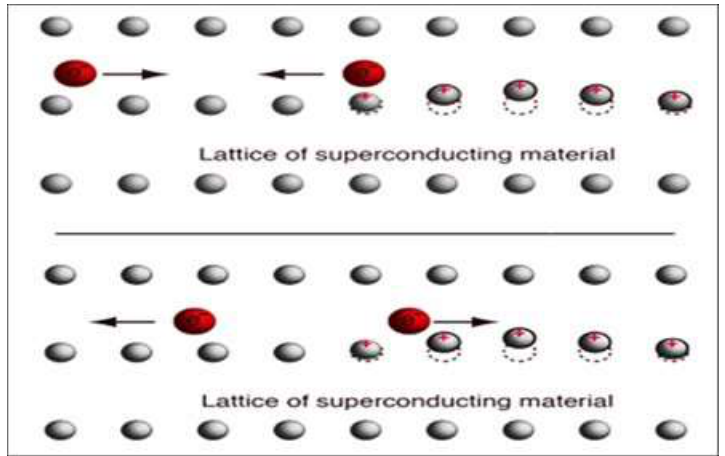
Figure 3: The generation of attractive force between electrons in a crystal. a) When an electron passes through the lattice, it attracts it and causes a little wave along its path. b) The displacement attracts another electron traveling in the opposite direction